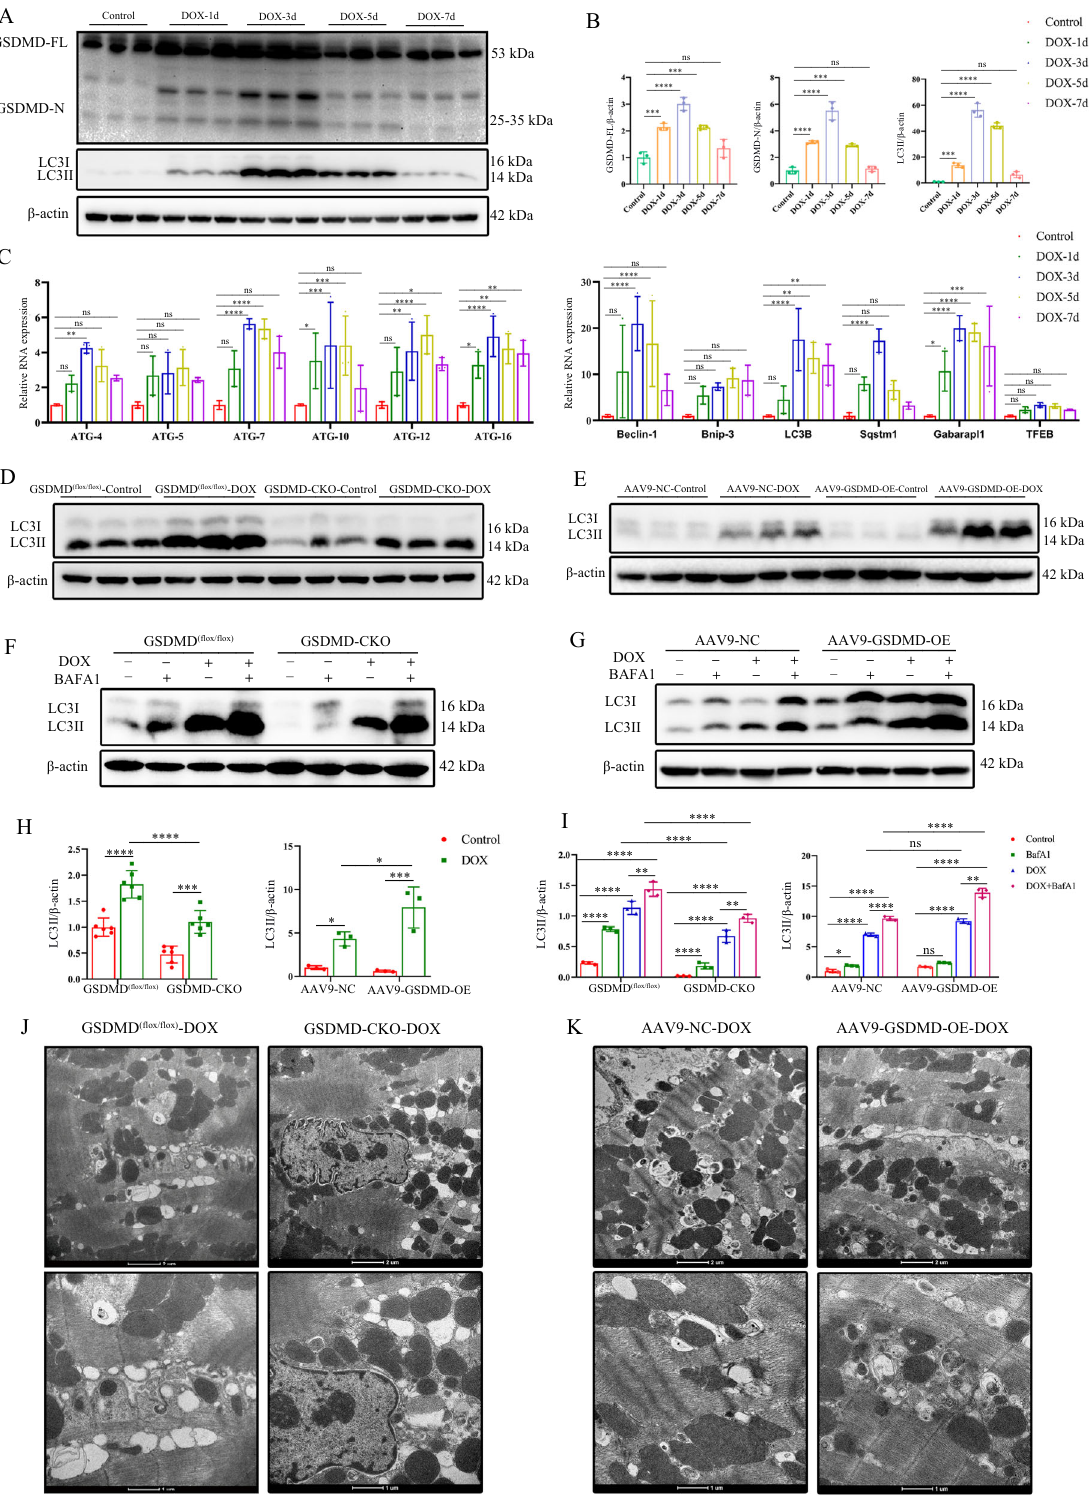
Sqstm 1/ p 62 genes. The expression of most genes showed a similar trend to that of protein expression (Fig. 4C), re fl ecting the response to DOX. Therefore, we selected day 3 as the time of cardiac intervention in mice for subsequent exploration of